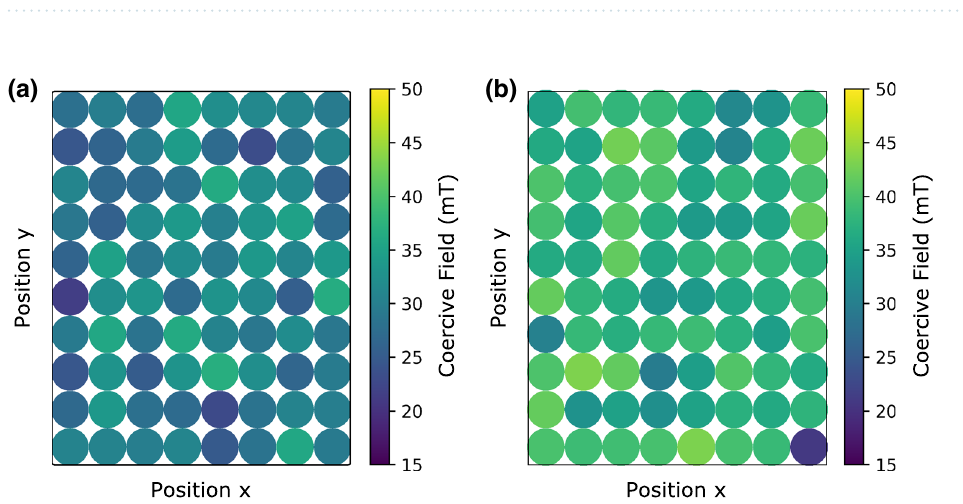
Figure 4. The coercive field distribution of an 8 by 10 array of microdisks on ( a ) Si and ( b ) PMN-30PT substrates. Each circle represents a